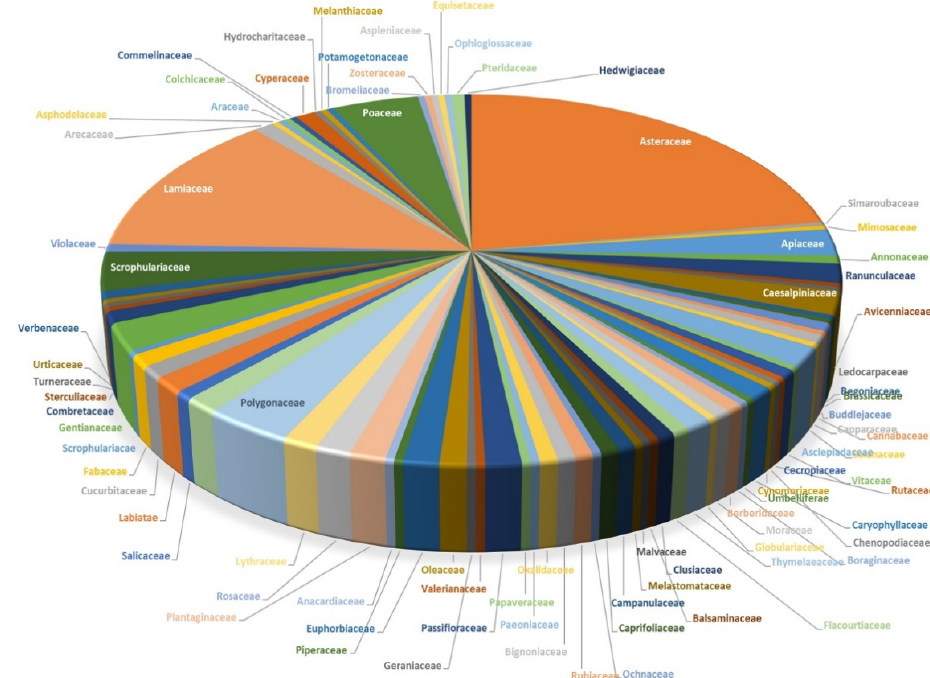
Figure 2. Distribution of luteolin compounds in the plant kingdom. The presence of luteolin in various plant families is represented in the pie chart based on the number of species in each fam- ily.